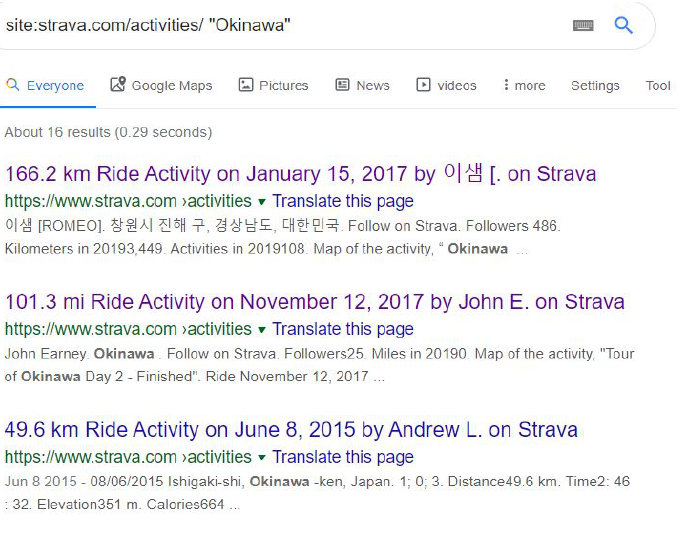
Figure 5. Accessing activity maps on